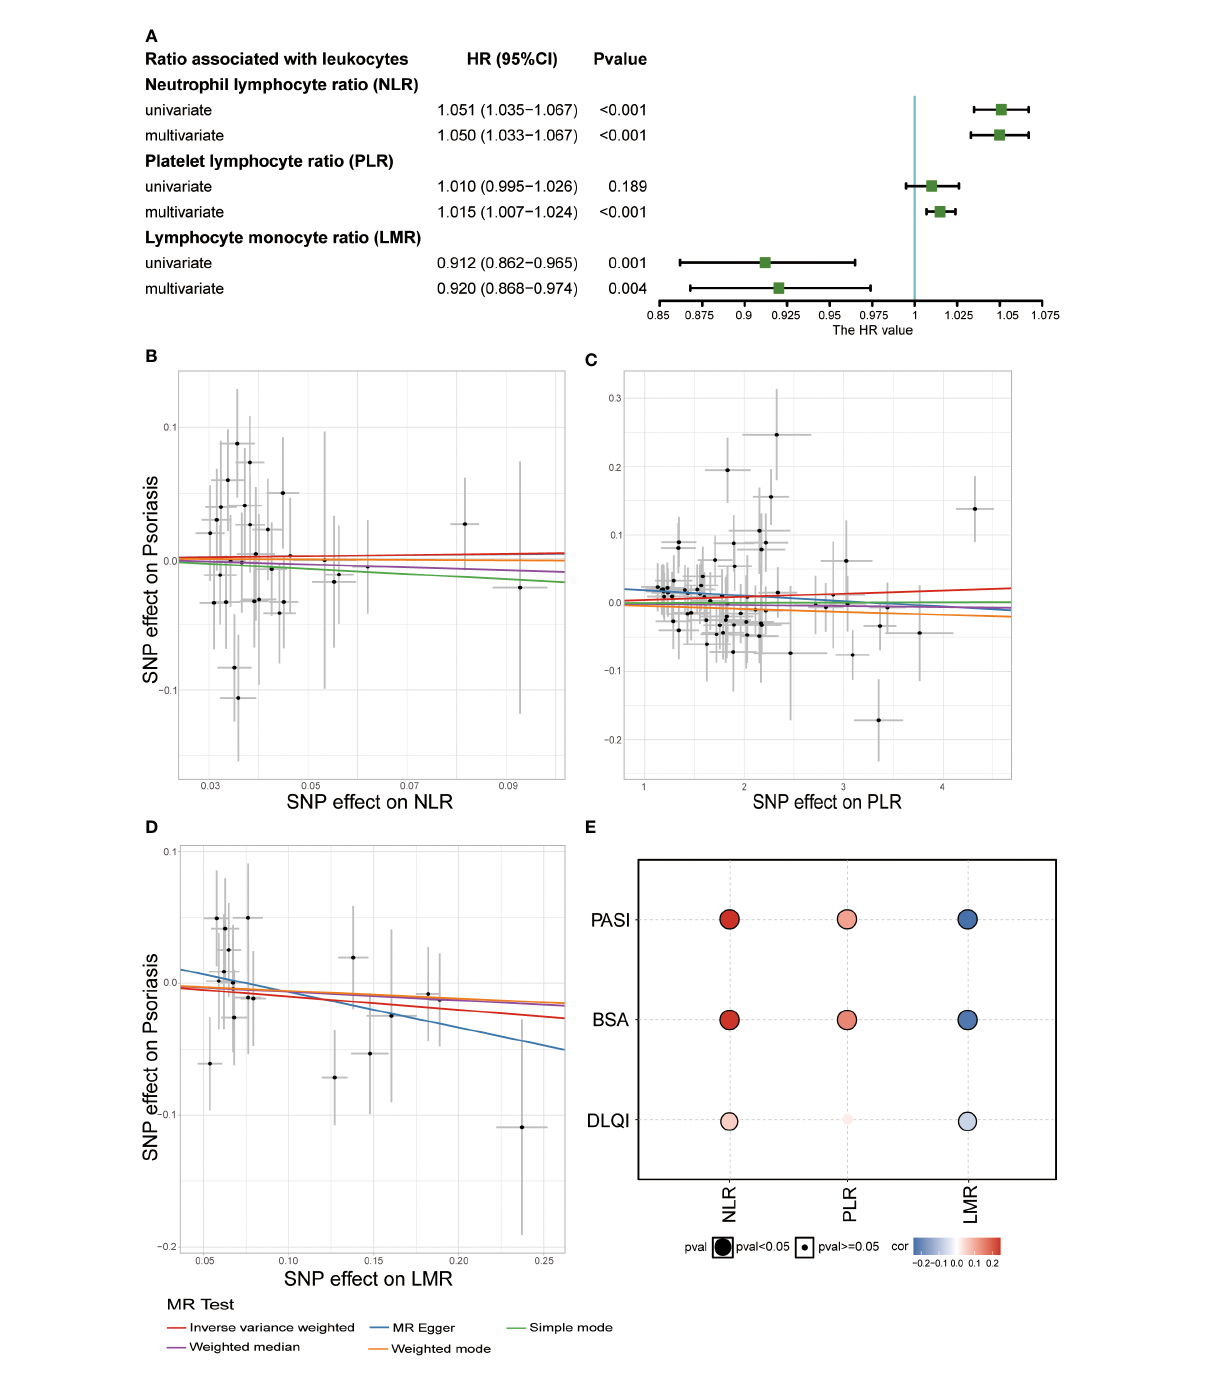
FIGURE 4 Relationship between white blood cell ratios (NLR, PLR, and LMR) and psoriasis. (A) Result of observational study about white blood cell ratios (NLR, PLR, and LMR) and psoriasis in UKB (Covariates included sex, age, BMI, smoking status, and alcohol drinking status and three ratios in multivariate Cox regression). (B) Scatter plot of MR analysis related to NLR and psoriasis. (C) Scatter plot of MR analysis related to PLR and psoriasis. (D) Scatter plot of MR analysis related to LMR and psoriasis. (E) Correlation between the three ratios and severity of psoriasis (Spearman ’ s